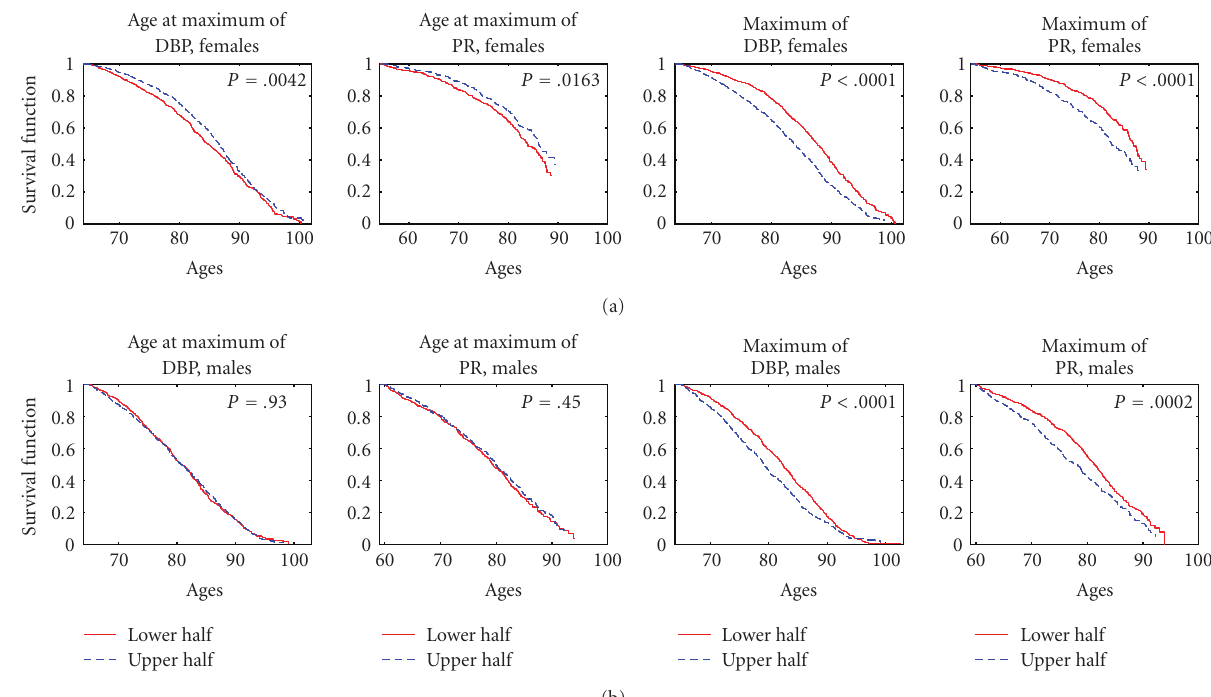
Figure 5: Kaplan-Meier estimates of survival functions for females (a) and males (b) having ages at reaching the maximum and the estimated maximal value (see Section 2) of di ff erent physiological indices from the lower and upper halves of empirical distributions of these risk factors for respective indices; P denotes P value for the null hypotheses about the equality of the survival curves in the strata evaluated by the log-rank